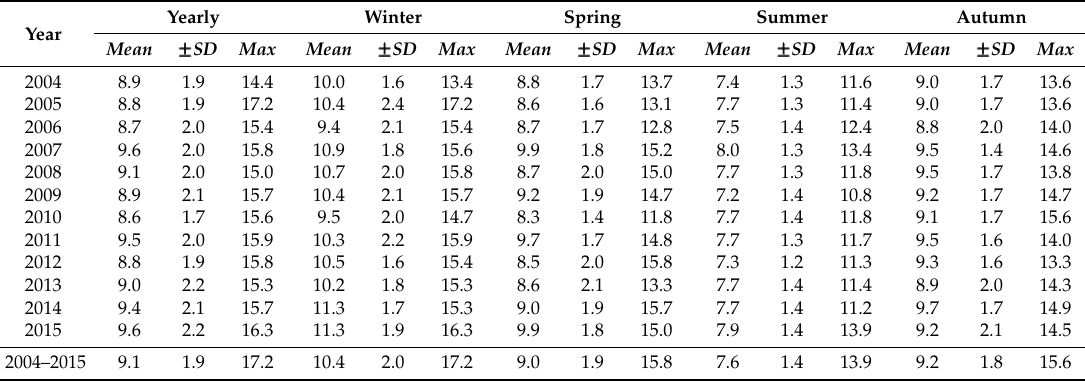
Table A5. Summary statistics from annual and seasonal analyses of T E (s) at